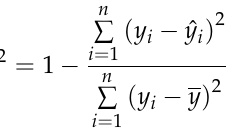
Figure 5. MSD of cellulose acetate–formaldehyde model.